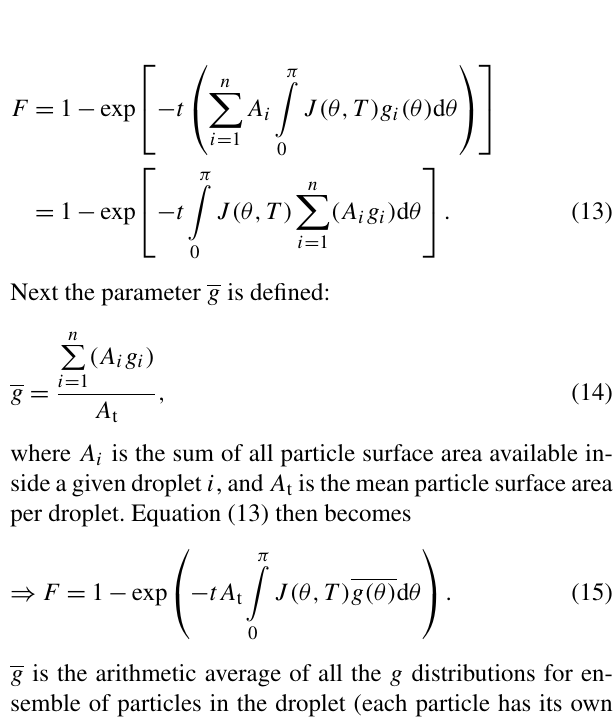
Figure 4. (Top) Schematic summarizing the procedure for determining the critical area. (a) The frozen fraction freezing curves shift to lower temperatures initially due solely to the decrease in total surface area of the INPs (curves 1 and 2). As the total surface area of the particles is decreased below the critical area threshold ( g (cid:54)= g) the slope of the freezing curve also broadens because the effective distribution of ice nucleating sites has changed – more external variability has been introduced (curve 3). (b) Ice active site density ( n s ) retrieved from the frozen fraction plots on the left for the same three particle concentration systems. Above the critical area limit ( g = g) the two n s curves are essentially the same, but below the critical area threshold (g (cid:54)= g) n s increases, even though the same particle species was measured in all three experiments. These exemplary frozen fraction and n s curves were produced by fitting a g distribution to droplet freezing measurements of illite mineral particles from Broadley et al. (2012). (c) Schematic summarizing how g ∗ is retrieved from g using n draws . In each draw a random contact angle from the full range of contact angles [0, π ] is chosen after which the value of g ∗ at that contact angle (right) is assigned the value of g at the same contact angle